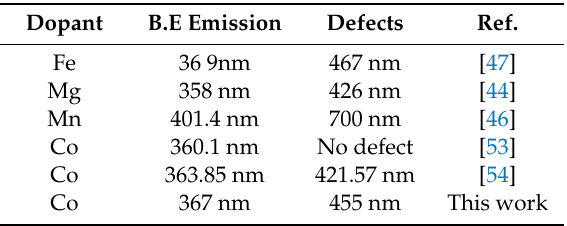
Table 3. Comparison of PL properties various dopants in GaN